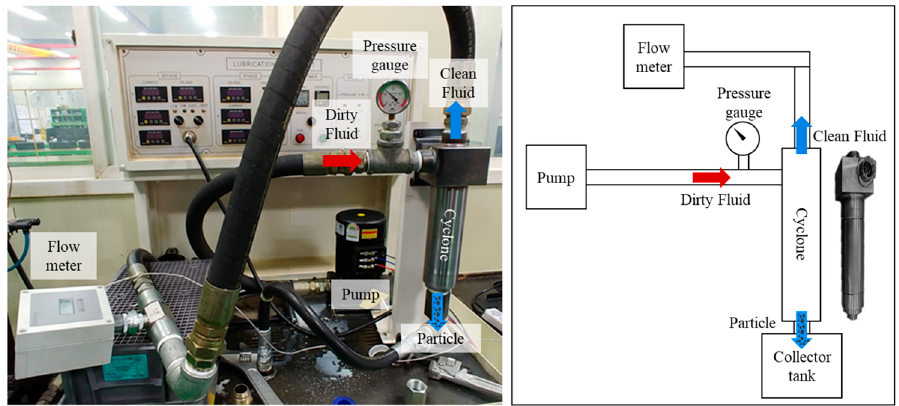
Figure 4. Experimental setup.